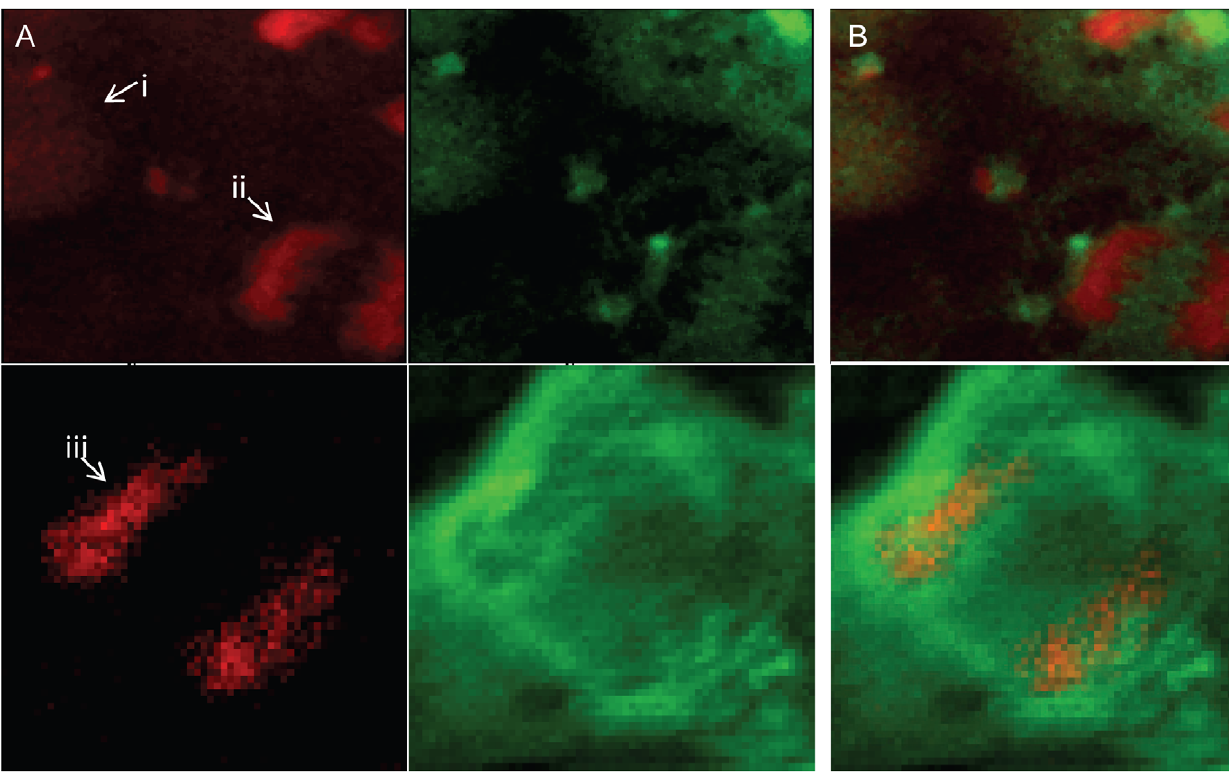
Figure 5. Zinc excluded from condensed chromosomes of mitotic cell. A. Raster scans mapping K a line fluorescence of phosphorus (red) and zinc (green) of an interphase (i) and mitotic (ii, iii) cells. B. Overlay demonstrating overlap of zinc and phosphorus in the interphase cell and mutual exclusion in the anaphase cells. The first row of images was obtained with x-ray beam spot size of 0.4 6 0.3 um with step sizes of 0.2 um. Second row was obtained with 0.6 6 0.8 um spot size and a 0.5 um step size.